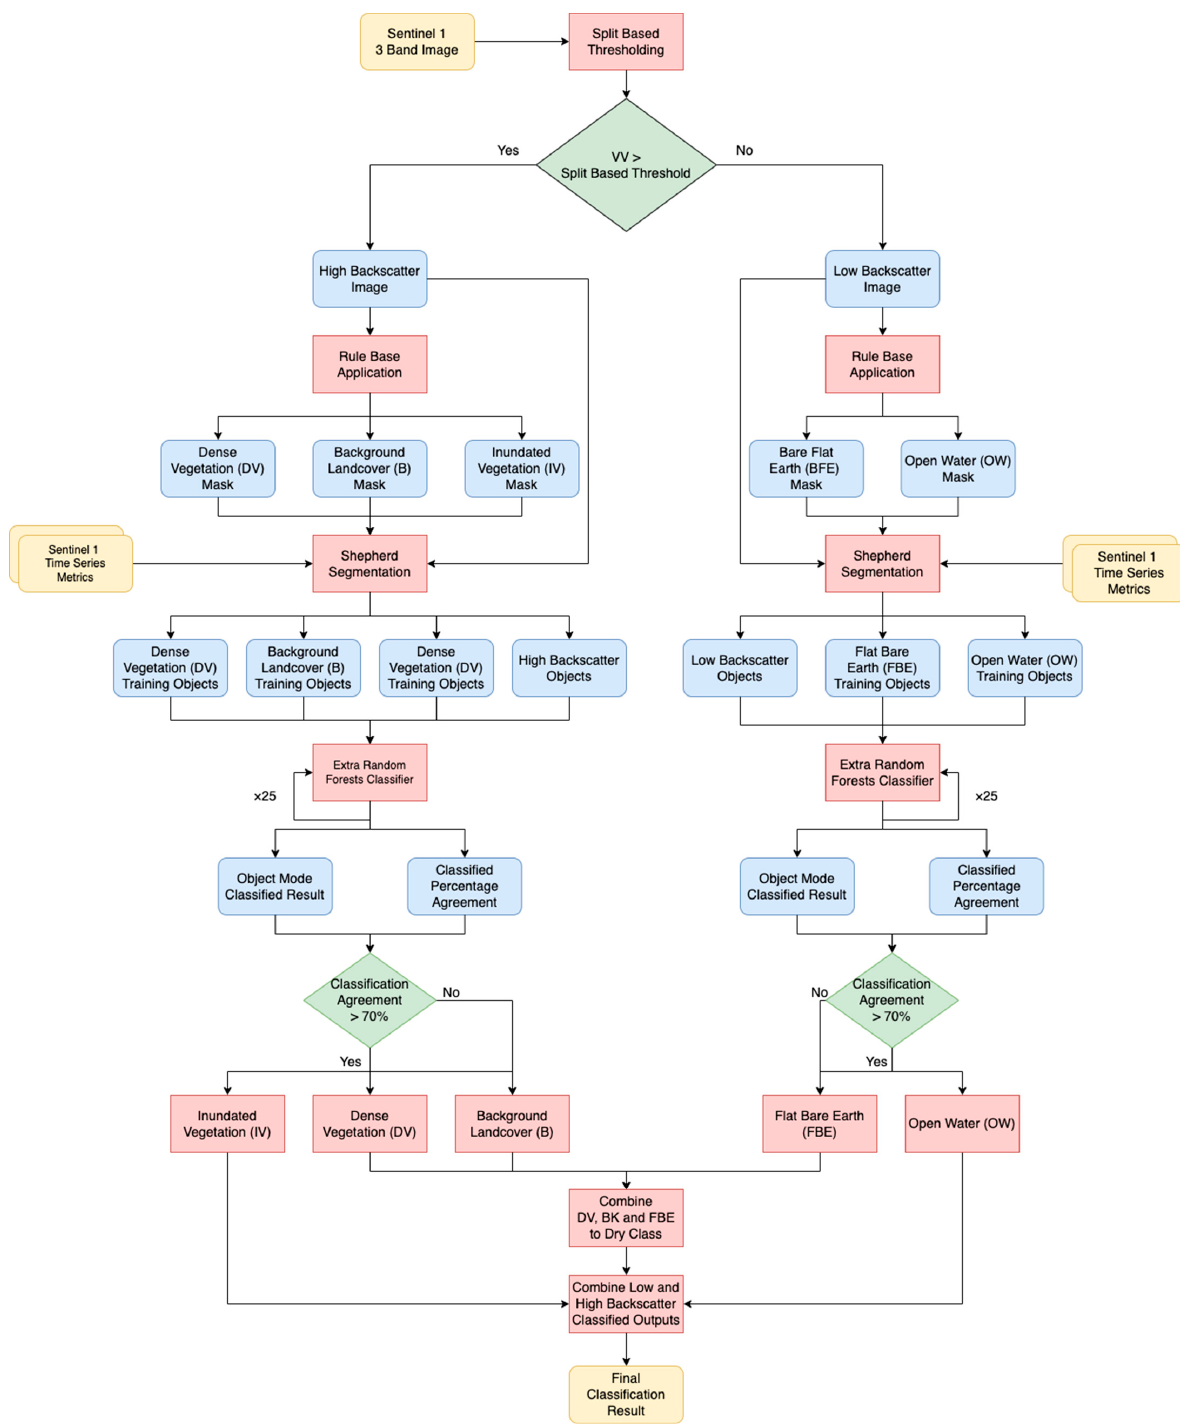
Figure 3. Flow diagram summarising the RadWet Sentinel-1 image classi fi cation processes for wetland mapping.